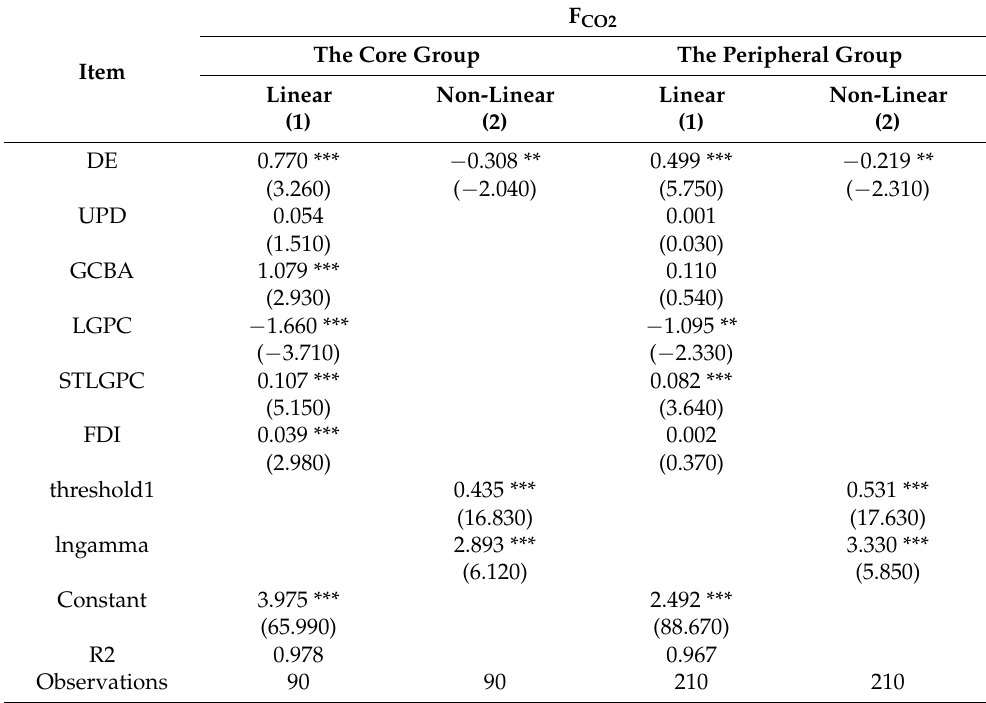
Table 11. Heterogeneity test